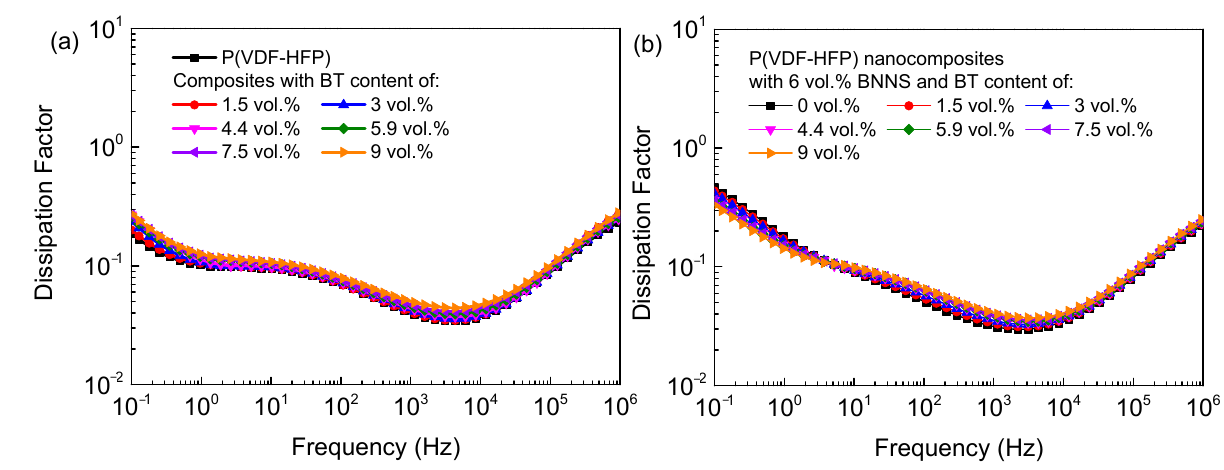
Figure 4. Frequency-dependent dissipation factor of ( a ) the P(VDF-HFP)/BT nanocomposites and ( b ) the ternary nanocomposites with 6 vol.% BNNSs.